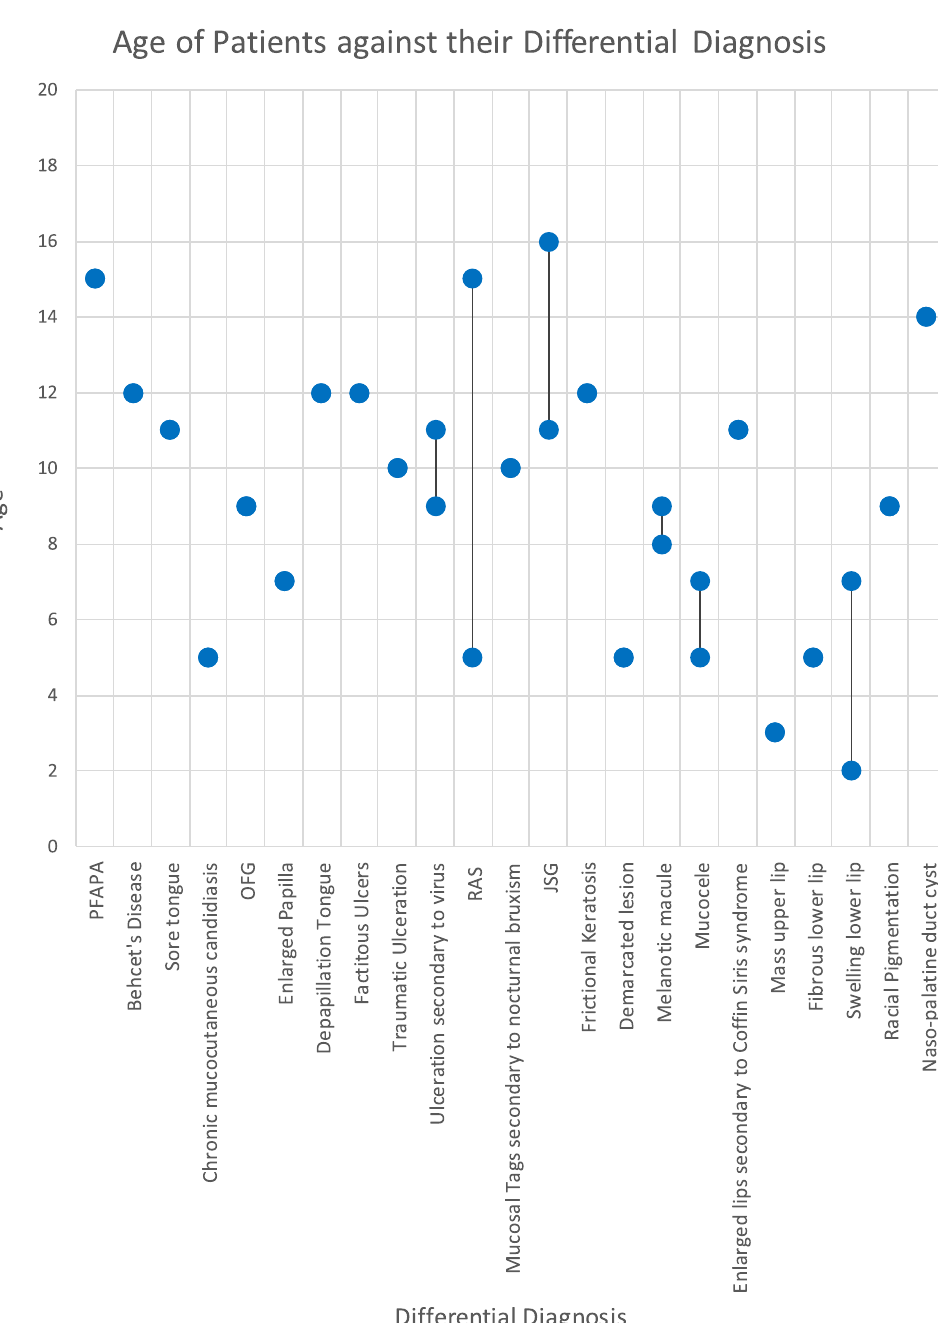
Fig. 2. A graph showing the age of patients against their differential